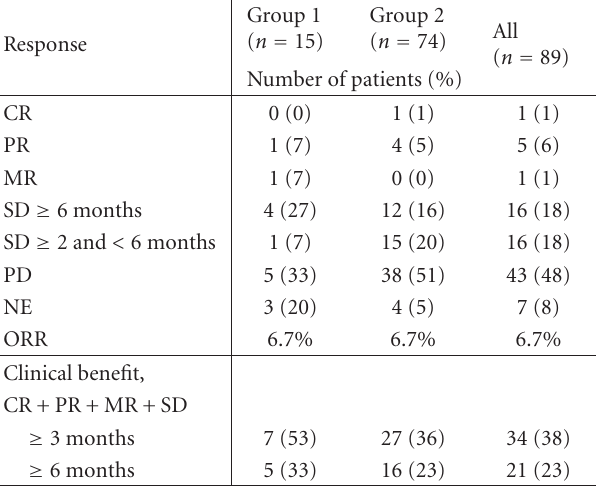
Table 3: Best response. CR: complete remission; PR: partial remis- sion; MR: minimal response; SD: stable disease; PD: progressive dis- ease; NE: not evaluated; ORR: overall response rate.